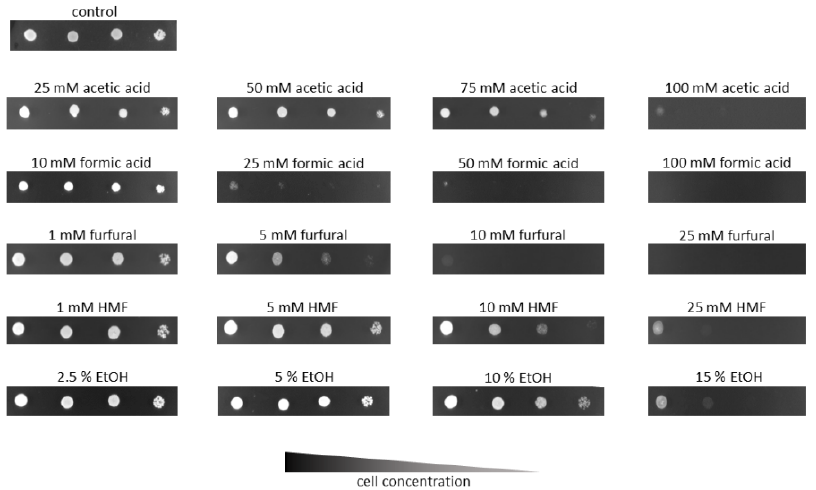
Figure 2. Growth curve of I. orientalis KJ27-7 at different temperatures. OD 600 measurement of I. orientalis KJ27-7 in YNB-D media, which contains 20 g L − 1 glucose incubated at 20 ◦ C ( υ ), 26 ◦ C ( λ ), 37 ◦ C ( π ), or 42 ◦ C ( ν ) after 24, 48 and 72 h. Displayed are mean values ± SD of four independent experiments each performed in duplicates.